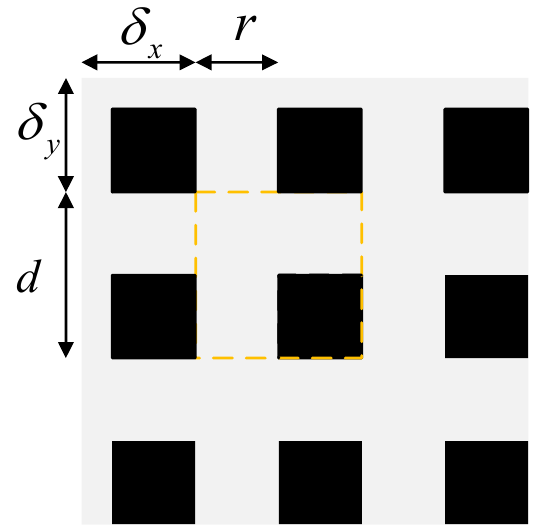
Figure 22. Schematic diagram of GridMask.